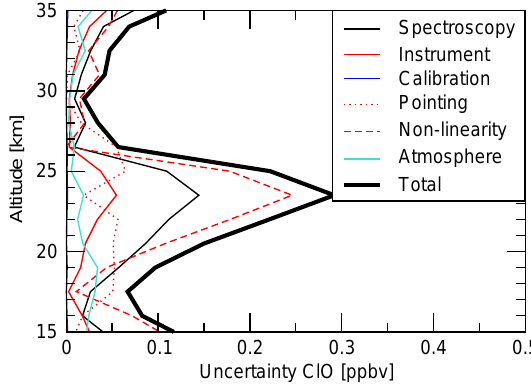
Fig. 10. The difference between the TELIS and MLS ClO profiles is plotted (solid line). The dashed lines indicate the RSS of the retrieval errors and the estimated systematic effects of both TELIS and